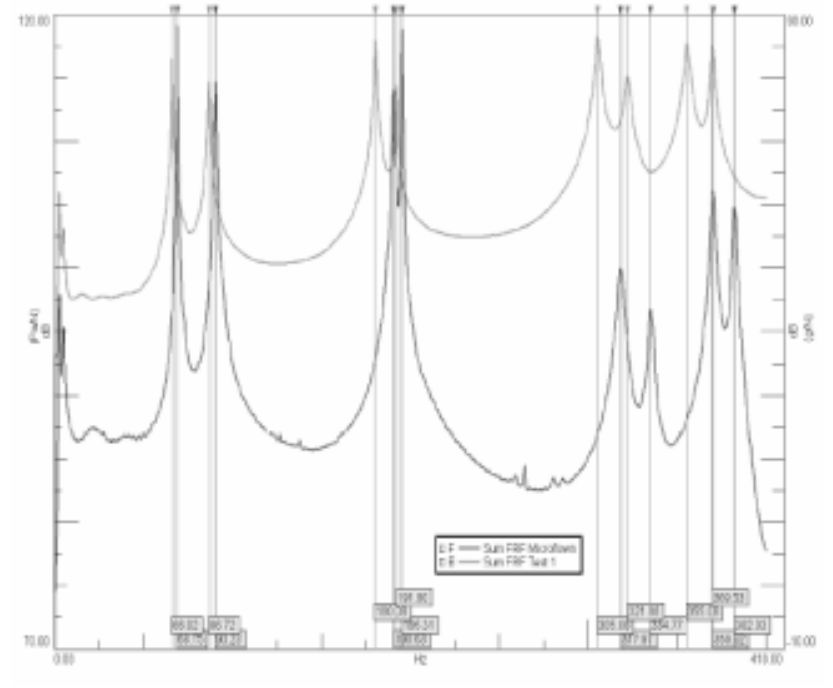
Fig. 4. FRF sum accelerometer (light-gray) vs microflown (dark-gray), plate test structure.